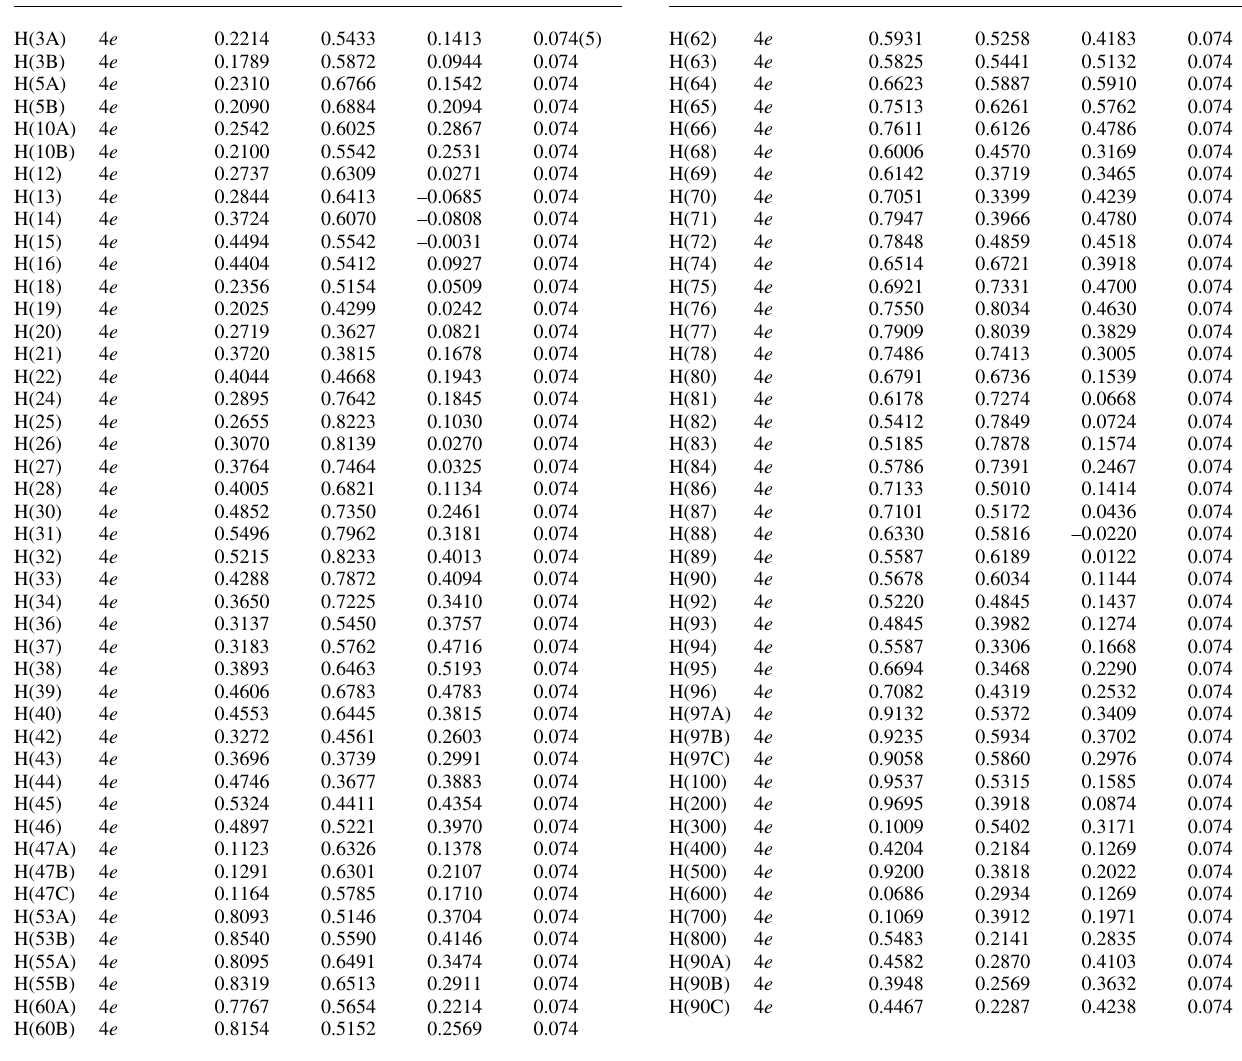
Table 2. Atomic coordinates and displacement parameters (in Å 2 )